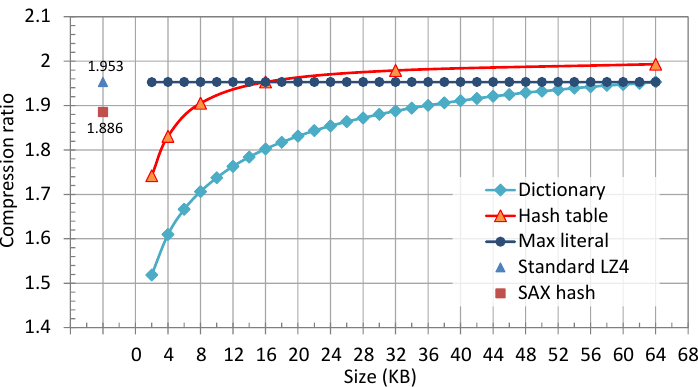
Figure 4. The compression ratio performance with different algorithm